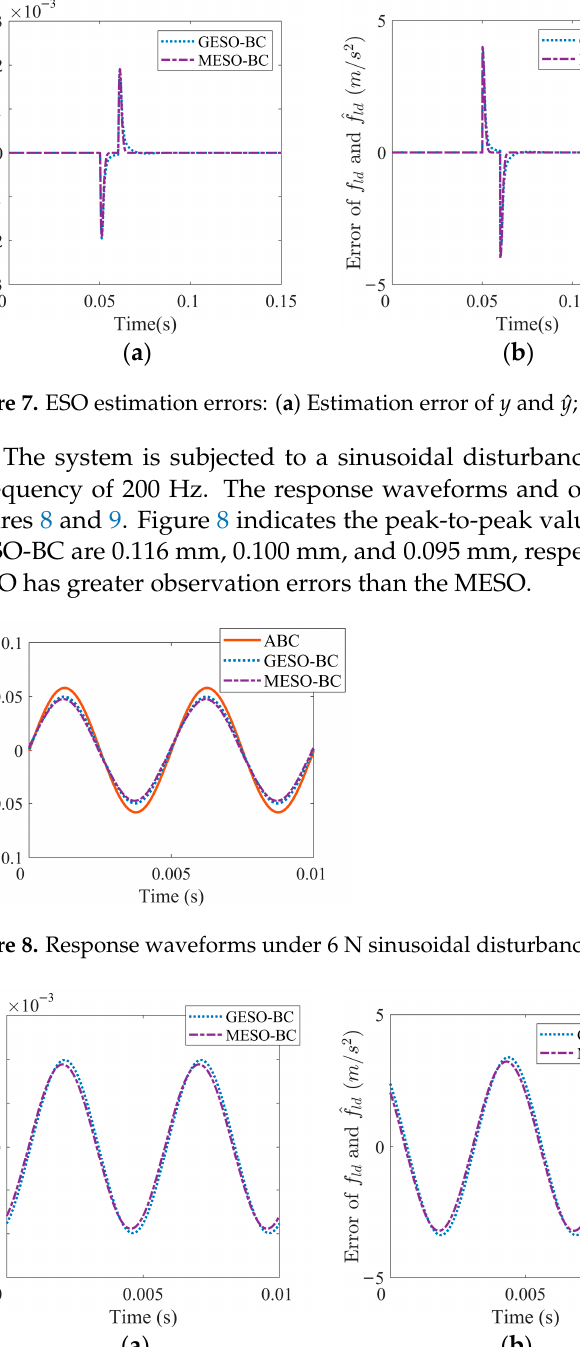
Figure 6. Response waveforms under 3 N pulse disturbance simulations.